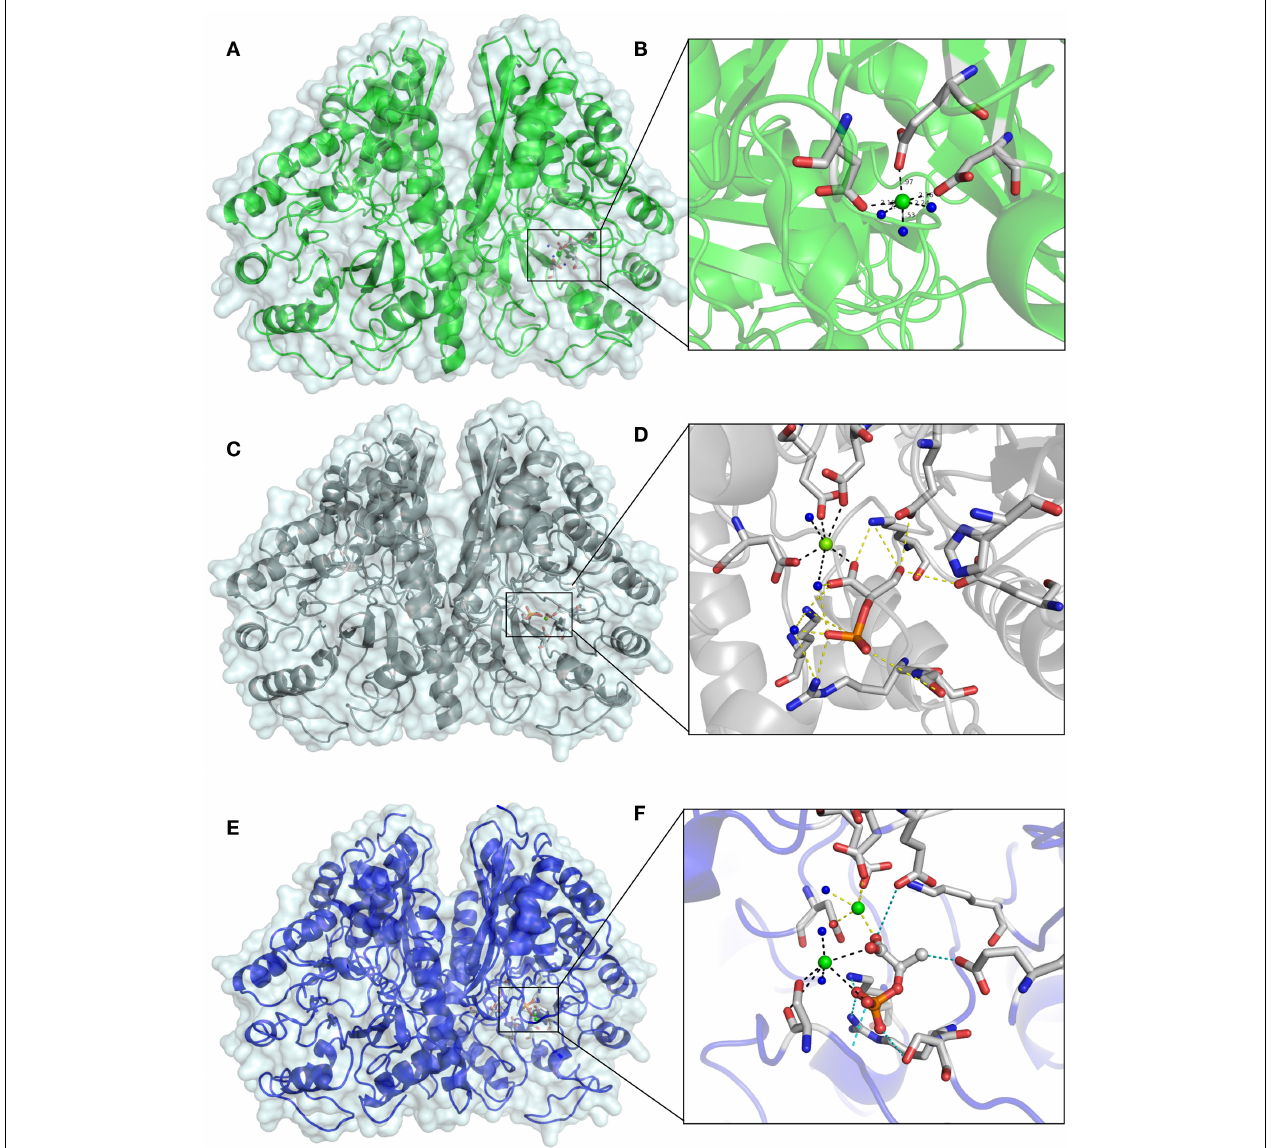
FIGURE 5 | Differences in the active site of crystal structures of C. aurantiacus enolase . The active sites of native EnoA in green (A,B) 2-PGA structure in gray (C,D) , and PEP structure in blue (E,F) are shown in overall (A,C,E) and close view (B,D,F) .